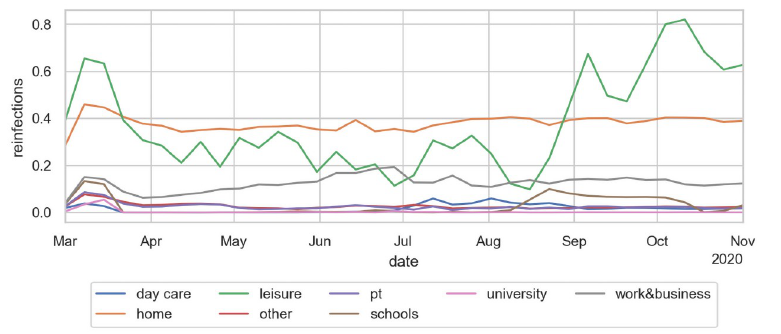
Fig 15. Reproduction number per activity